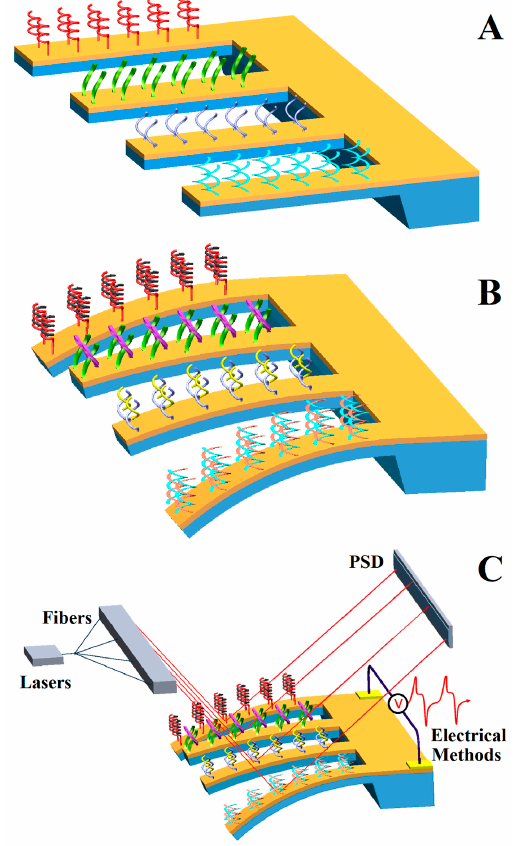
Figure 1. Detection procedure of the genetic-probe-modified microcantilever sensor: ( A ) probe immobilization; ( B ) complementary hybridization; ( C ) signal processing. 2.1. Probe Immobilization In probe immobilization, a nucleic acid sequence with a known order is used as a sensing element to modify the microcantilever surface and form a sensor. Probe immo- bilization is a key technology of sensor preparation, which determines the specific, proximity, adhesion, and binding force of the sensitive layer to the sample [19]. The